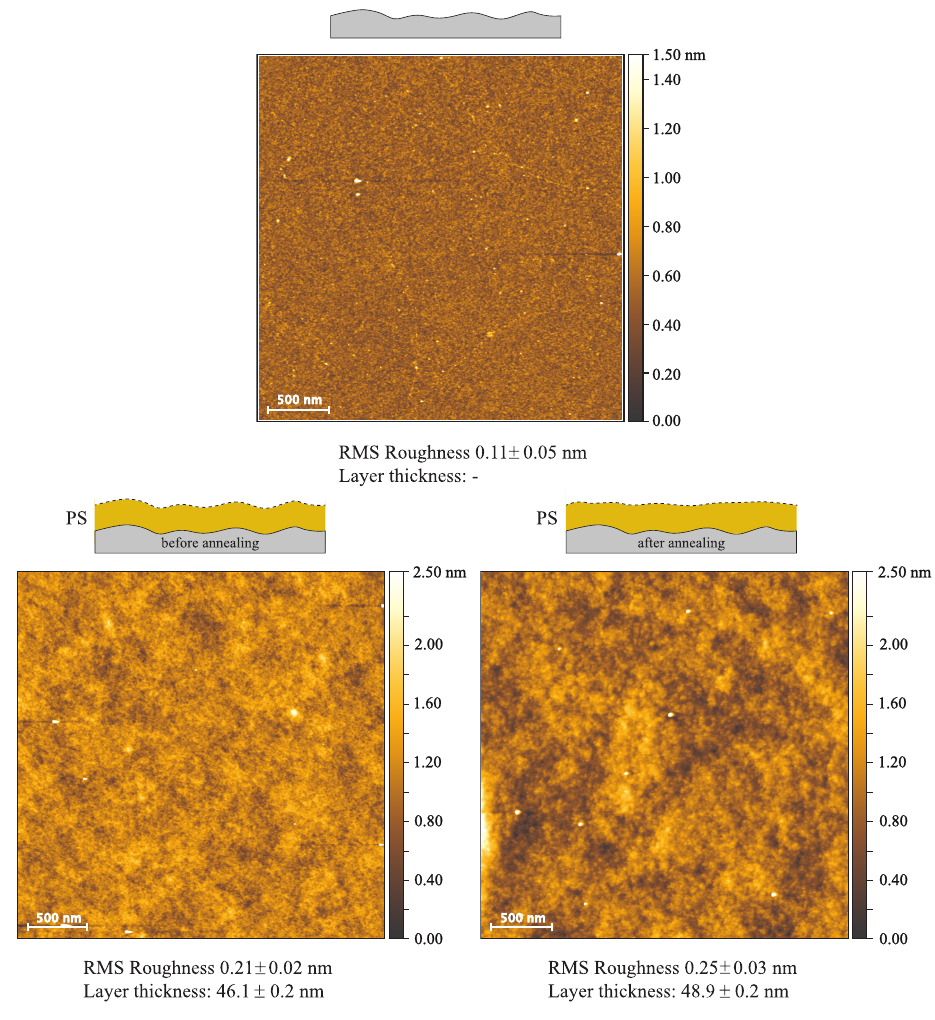
Figure 5. AFM topography images of a bare silicon surface, a spin-coated PS film without solvent vapor annealing and with annealing. Layer thicknesses were measured via ellipsometry and RMS roughnesses of topography images were determined with Gwyddion